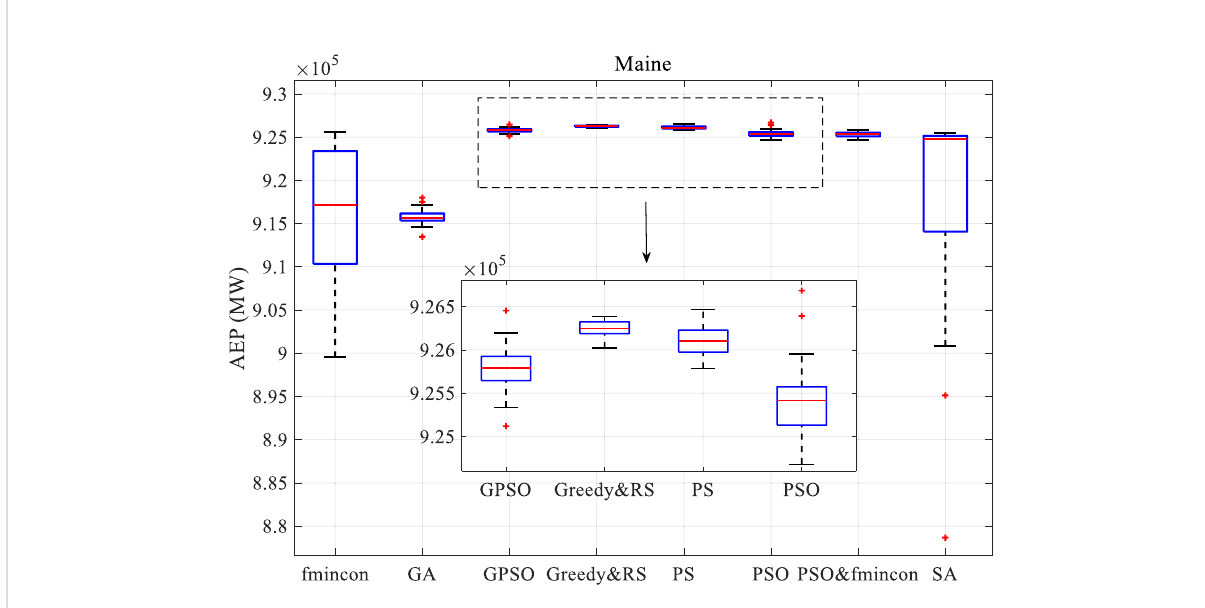
FIGURE 13 Boxplot of wind farm AEP using different optimization methods.